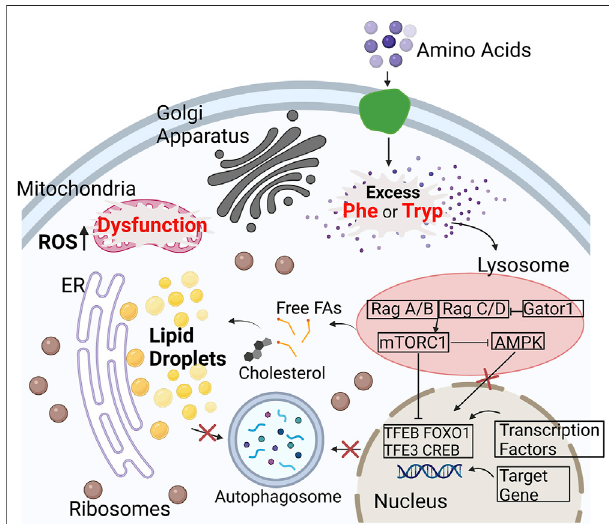
FIGURE 1 | Illustration of how excess amino acids upregulate the mTORC1 pathway in cells. mTOR is a key regulator of lipid metabolism. With higher available nutrients, such as Phe (Phenylalanine) and Tryp (Tryptophan), mTORC1 is active and AMPK becomes inactive. mTOR inhibits the transcription factors, that include TFEB and TFE3, to block the targeting of transcriptional genes associated with the autophagy-lysosome (Chiacchiera and Simone, 2009; Thiem et al., 2013; Vadlakonda et al., 2013; Zhao et al., 2017). This ultimately results in lack of autophagy and start of lipophagy leading to an increase in lipid droplet accumulation and ROS. The increase in oxidative stress results in the dysfunction of the mitochondria and ER stress (Zhang et al., 2018; Paquette et al., 2021; Ralhan et al., 2021). Abbreviations: (AMPK), mechanistic target of Rapamycin complex 1 (mTORC1), (TFEB),